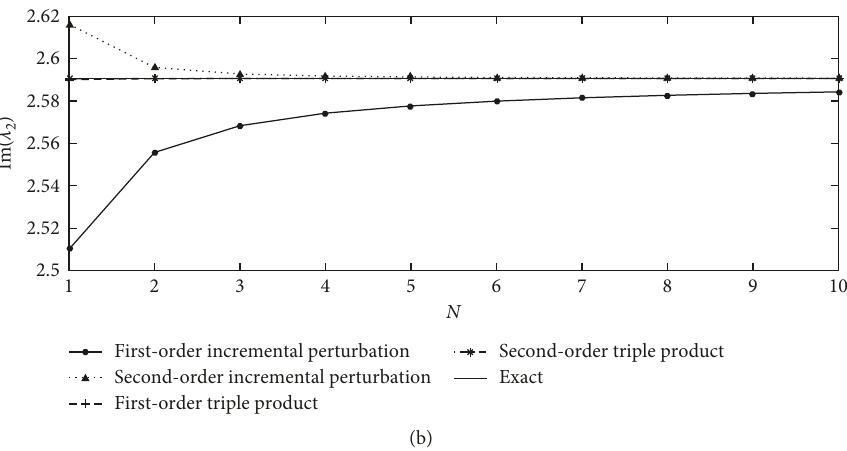
Figure 9: The imaginary parts of the approximate eigenvalues of the two-degree-of-freedom gyroscopic system as a function of N for σ � 1 . 37. Table 5: The real parts of the exact and approximate natural frequencies for the perturbed two-degree-of-freedom gyroscopic system at N � 10 for σ � 1 . 37. Exact